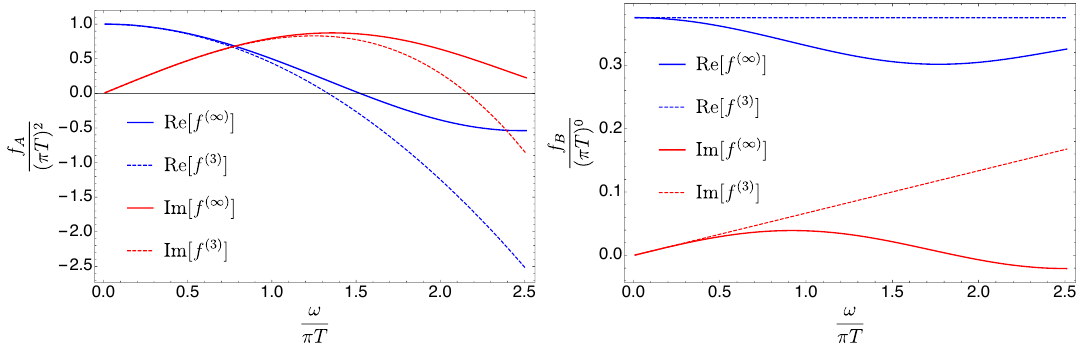
Figure 2 . Real and imaginary parts for the all order as well as third order drag force for the A component (left) and the B component (right) at (cid:12)xed k 2 = 0 as functions of ! . The all order drag force is depicted by solid lines labeled f ( 1 ) , while the dotted lines labeled f (3) represent the drag force obtained to third order in the gradient expansion